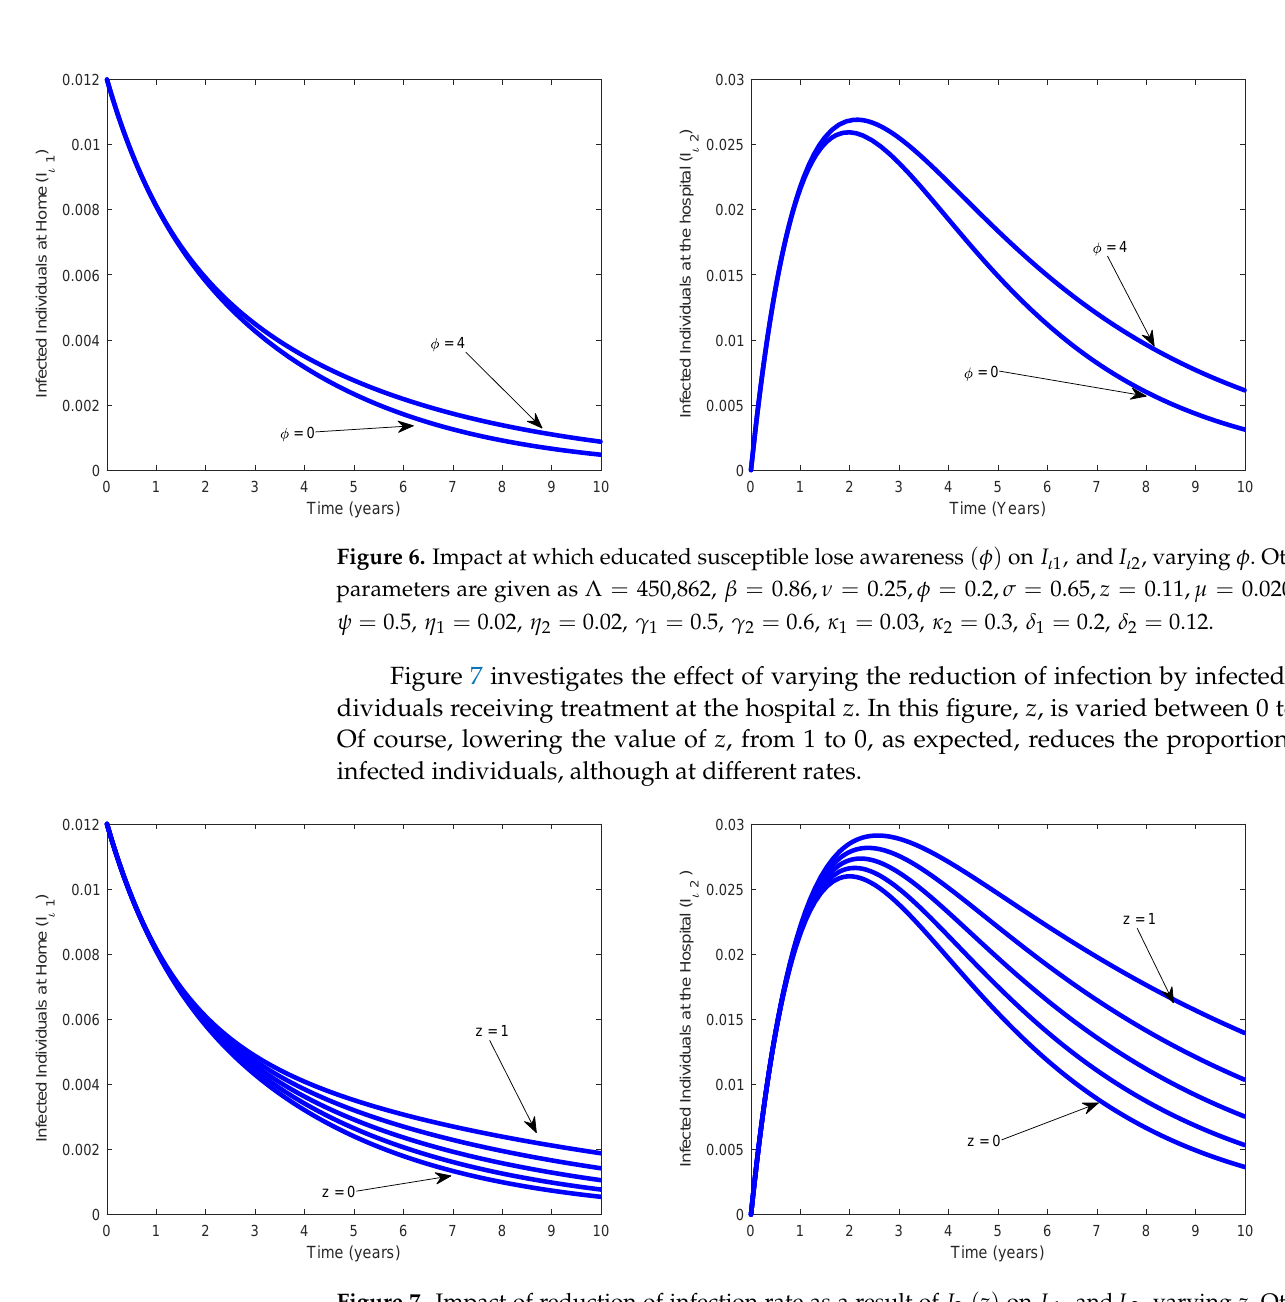
Figure 7. Impact of reduction of infection rate as a result of I 2 ( z ) on I ι 1 , and I ι 2 , varying z . Other parameters are given as Λ = 450,862, β = 0.86, ν = 0.25, φ = 0.2, σ = 0.65, z = 0.11, µ = 0.02041, ψ = 0.5, η 1 = 0.02, η 2 = 0.02, γ 1 = 0.5, γ 2 = 0.6, κ 1 = 0.03, κ 2 = 0.3, δ 1 = 0.2, δ 2 =